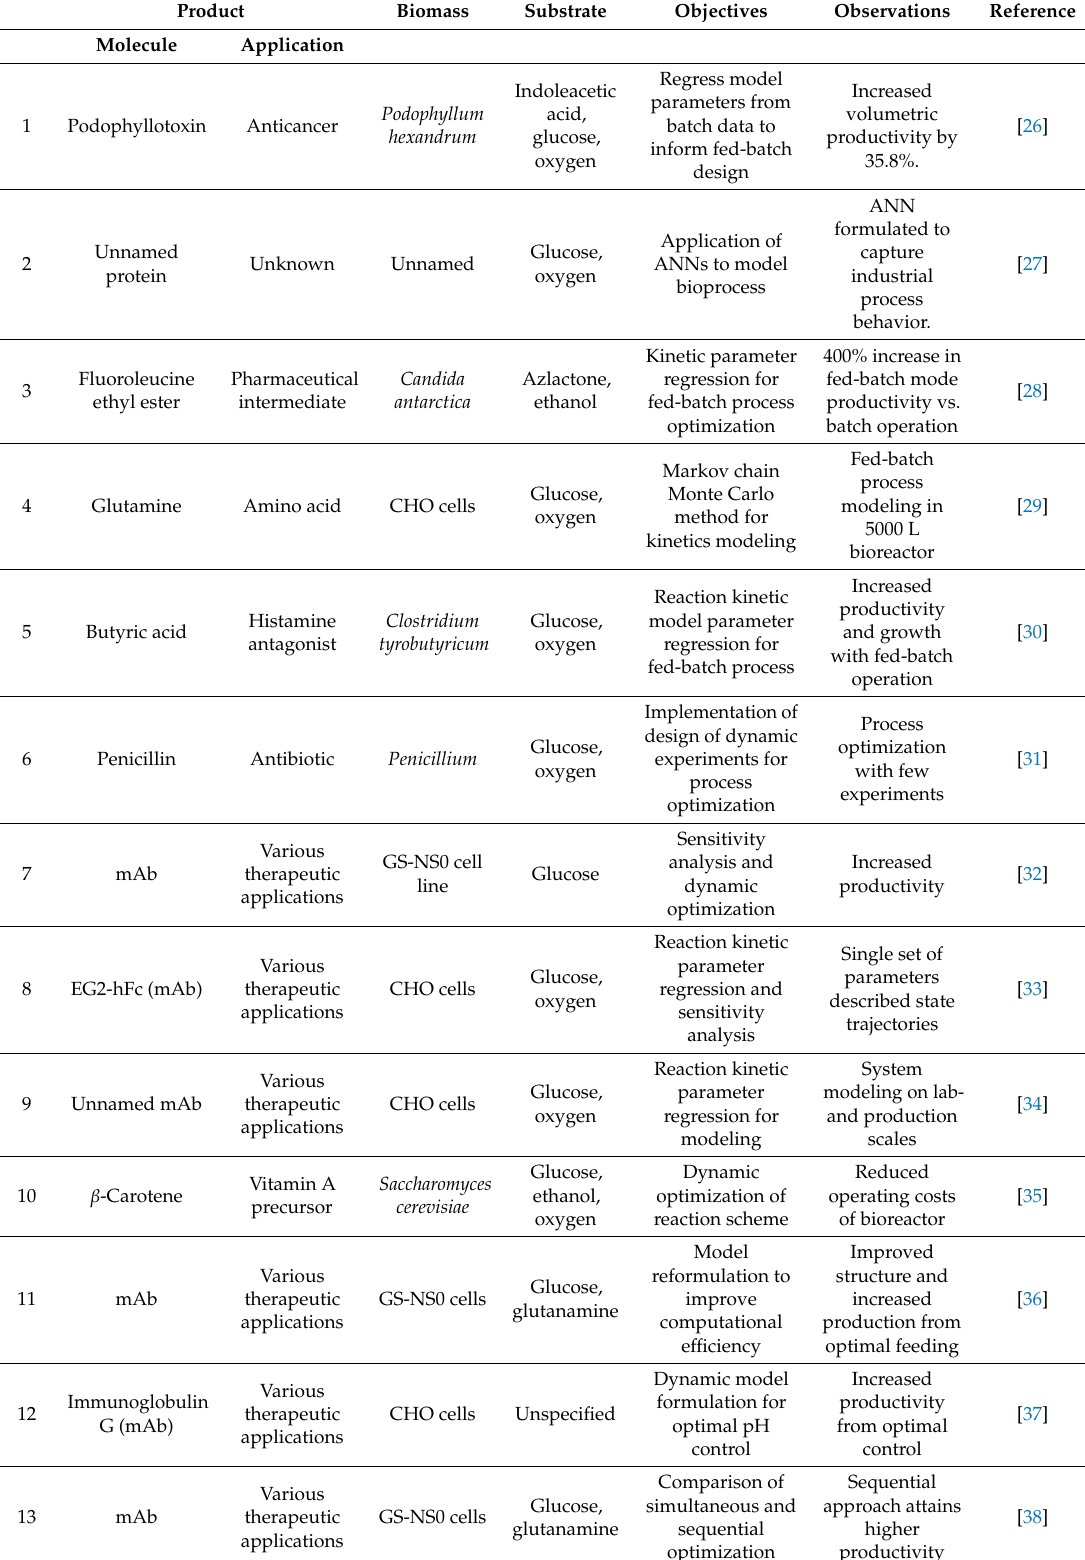
Table 2. Select modeling and optimization studies for fed-batch pharmaceutical